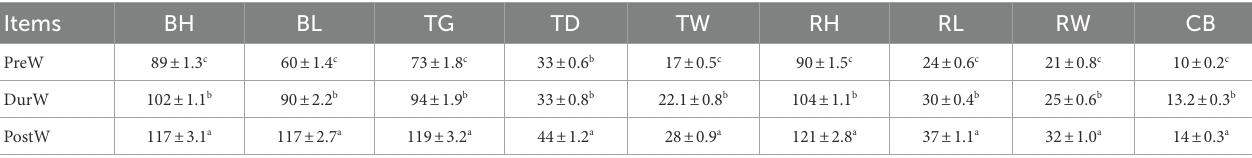
TABLE 1 Descriptive values for donkey foals are shown related to body measurement. Items